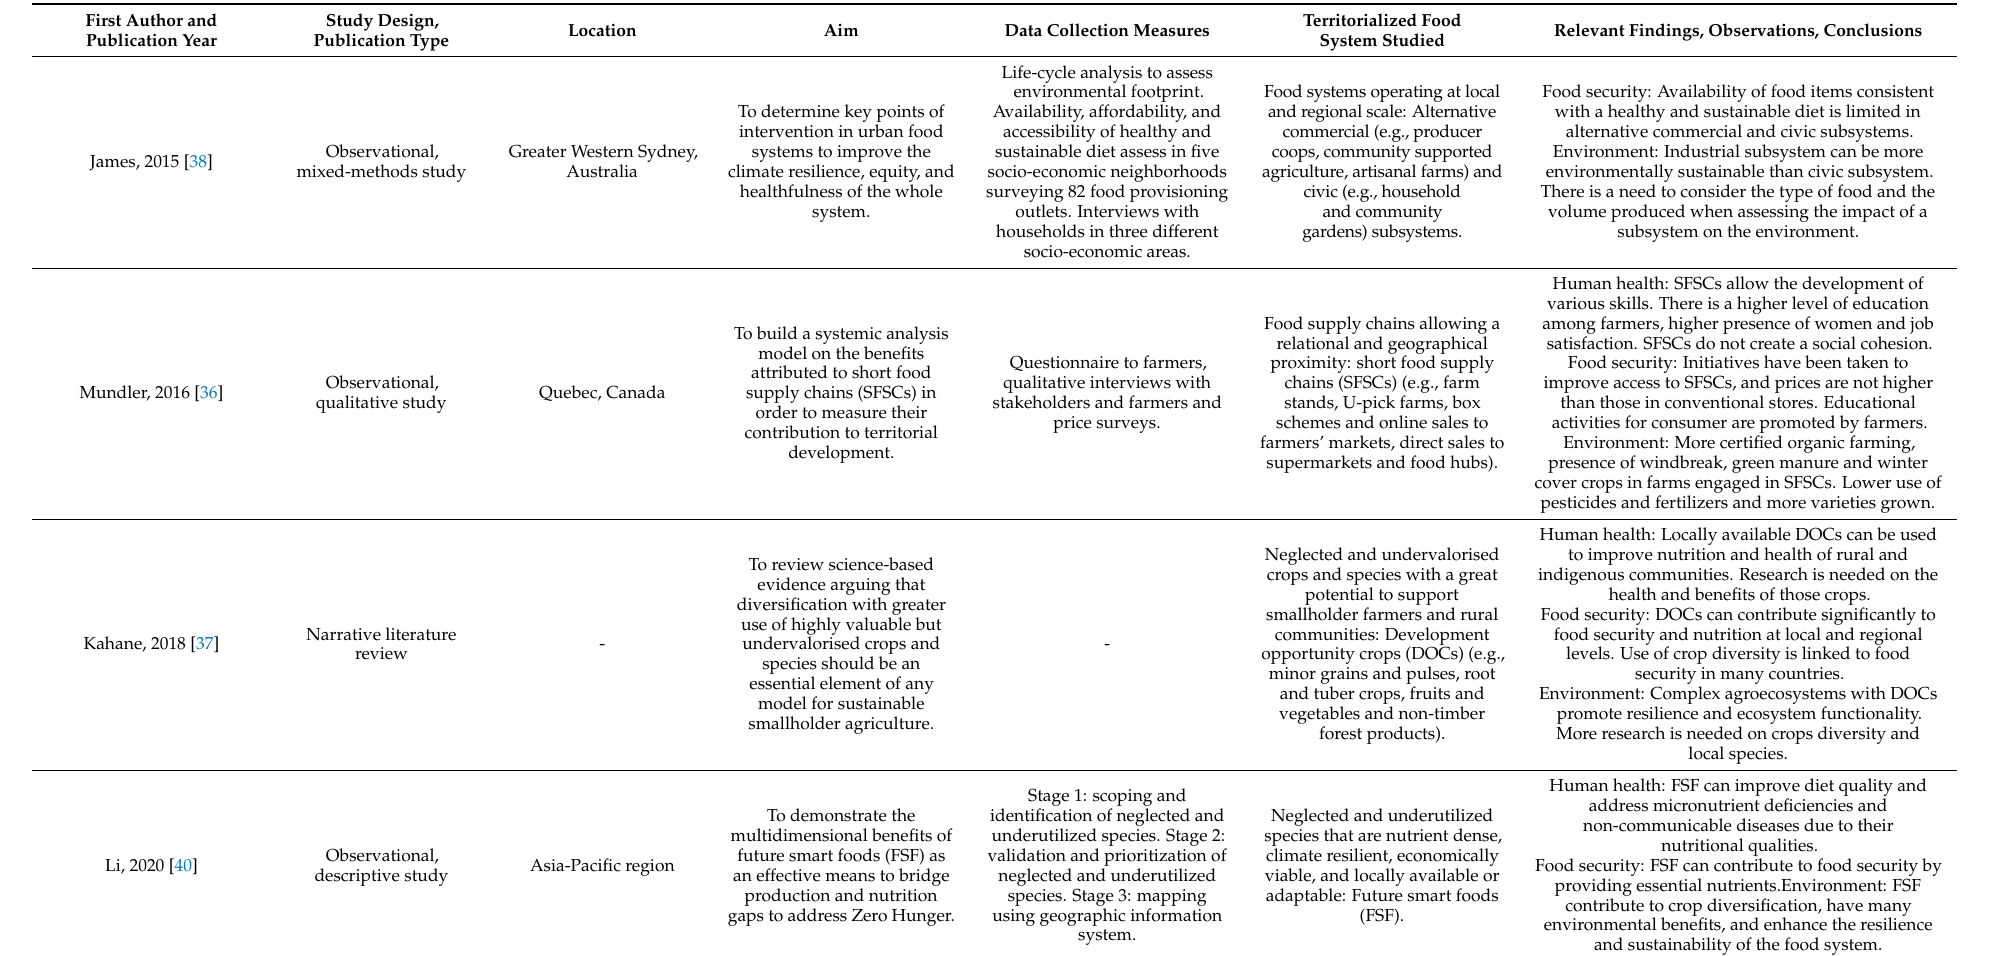
Table 2. Publications included in the rapid review of territorialized food systems ( n =